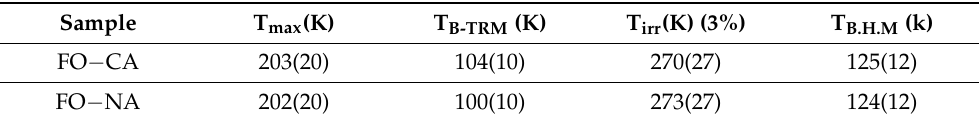
Figure 4. ZFC (full circle/squares) and FC (empty circle/square) magnetization curves measured at 2.5 mT. Table 3. Temperature Corresponding to the Maximum in ZFC Curve (T max ), Irreversibility Tempera- ture (T irr ), and Blocking Temperature (T B-TRM ) From TRM measurement and the blocking temperature from Hansen and Mørup approach (T B.H.M ) for FO − CA and FO − NA samples, uncertainties on the last digit are given in